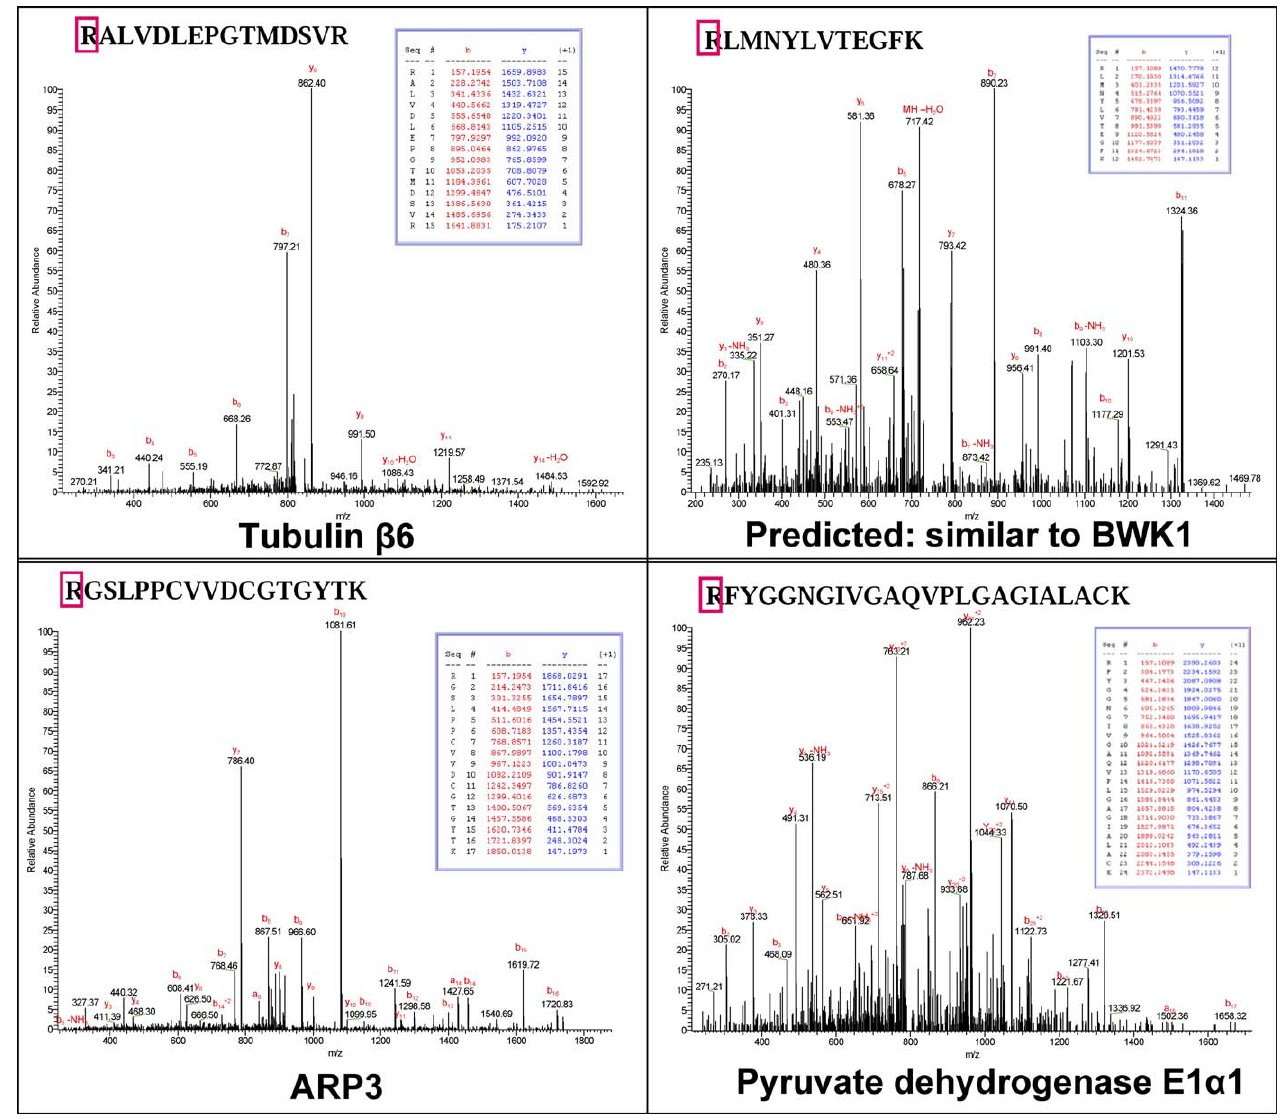
Figure 4. Selected MS/MS Spectra for the Arginylated Peptides Shown in Table 1 Peptide sequences are shown on top of each spectrum, with the added Arg boxed in red. Observed b and y ions are shown in red and blue, respectively on the MS/MS spectra and in the corresponding tables for each spectra. Generic names of the proteins are shown underneath the corresponding spectra. The spectra show peptides arginylated on N-terminal alanine (Ala), Leu, Gly, and phenylalanine (Phe) residues, all of which were previously believed to be unable to serve as an Arg acceptor site. Precursor mass accuracies for the shown spectra are 2.1 ppm (Ala), 3.8 ppm (Leu), 8.0 ppm (Gly), and 5.6 ppm (Phe). See Table 1 for accession numbers and arginylated positions and Dataset S1 for larger scale images of the MS/MS spectra for all identified